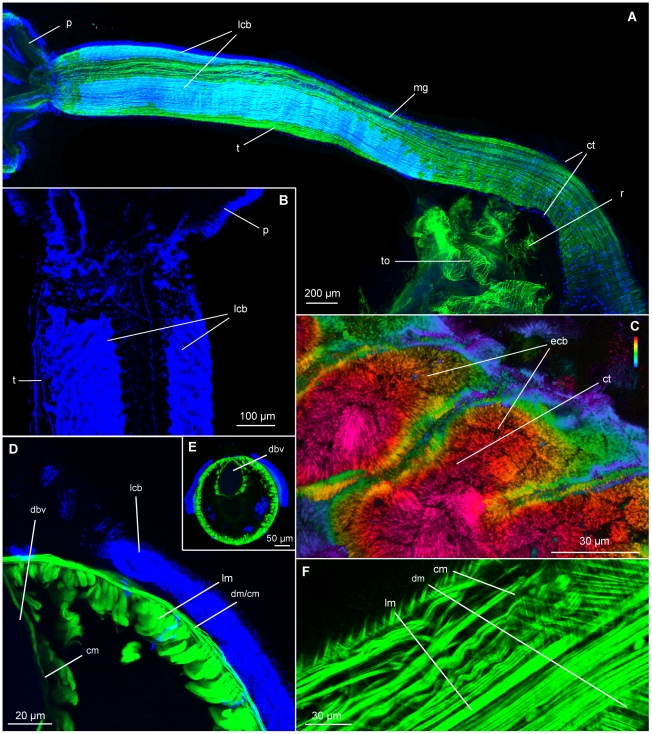
Confocal laser scanning microscopy (CLSM) of the trunk of Osedax mucofloris females.A: Dorso-lateral view of a complete specimen, lateral ciliary bands occupies half the length of the trunk. B: Dorsal view of the anterior part of the trunk, elliptical shaped cilia bundles are directed anteriorly from the lateral part of the trunk. C: Depth coded z-stack, the elliptical shaped cilia bundles constituting the lateral ciliary band are formed by ciliary tufts. D: Close-up of transverse section of a trunk. E: Transverse section of a trunk, note the muscularized dorsal blood vessel. F: Single z-stack image of the trunk musculature, longitudinal muscles beneath circular and diagonal muscles. Abbreviations: ciliary tufts (ct), circular muscles (cm), diagonal muscles (dm), elliptical ciliary bundles (ecb), lateral ciliary band (lcb), longitudinal muscles (lm), muscular gap (mg), palp (p), root structure (r), torn ovisac (to), trunk (t), dorsal blood vessel (dbv).